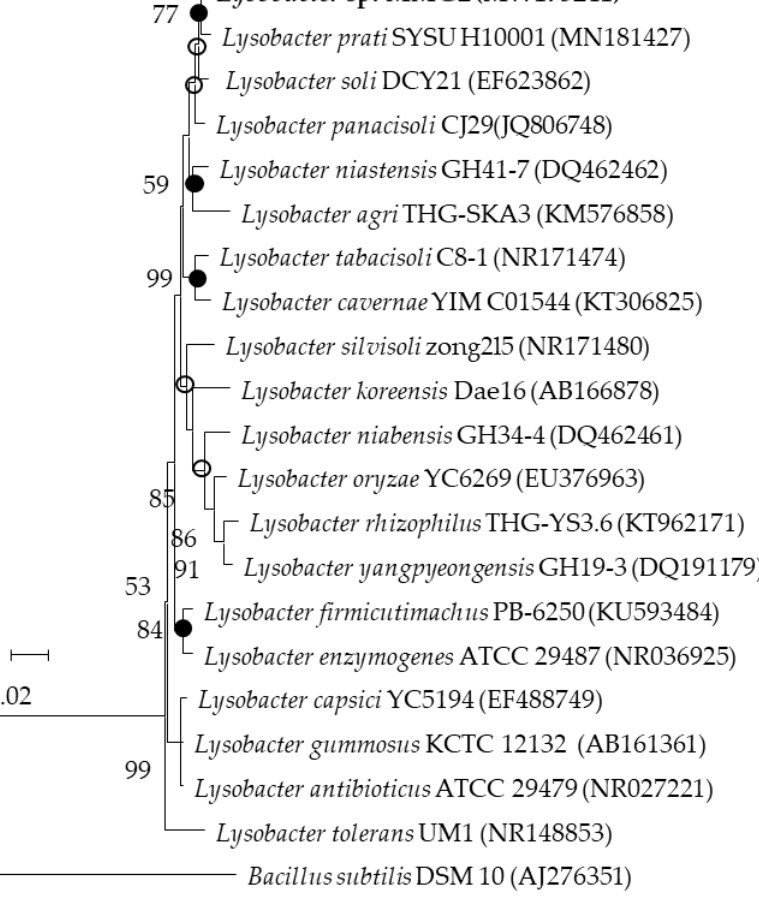
Figure 1. Phylogenetic tree of strain MMG2 within the genus Lysobacter . Bootstrap values are shown as percentages of 1000 replicates (only values >50% are shown). Filled circles indicate the corresponding nodes were recovered in trees generated with the ML and MP algorithm. Empty circles indicate the corresponding nodes were recovered using the ML algorithm. Bar, 0.02 substitutions per nucleotide position.